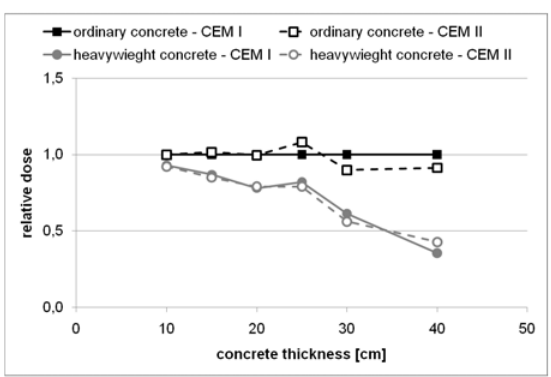
Figure 5. MCNPX simulations results for 0.1 MeV point source